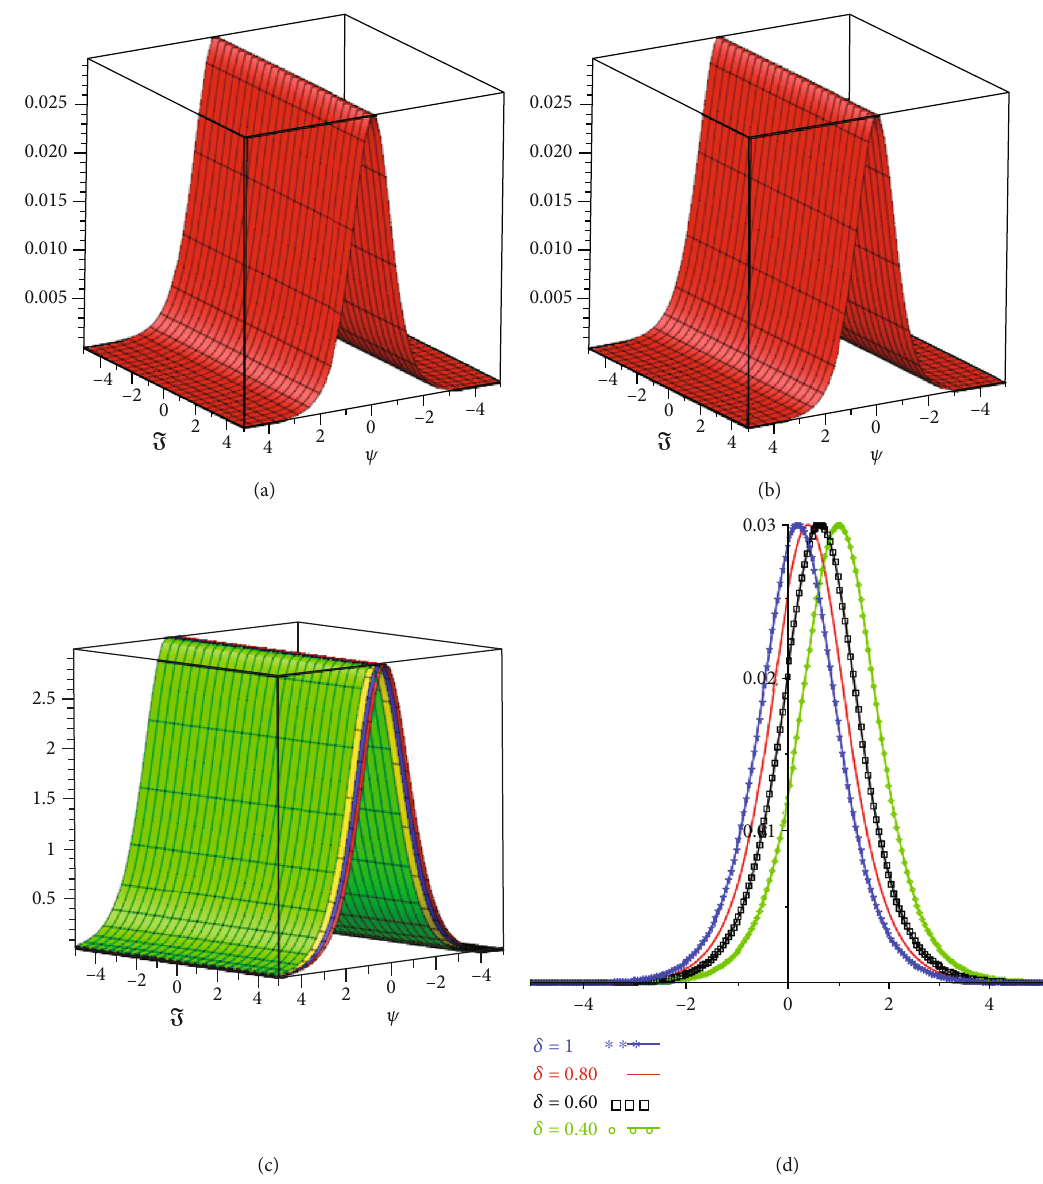
Figure 1: Example 1 solution graph (a) exact solution, (b) analytical solution at δ = 1, (c) analytical solution at various fractional-orders of δ , and (d) I = 0 : 5